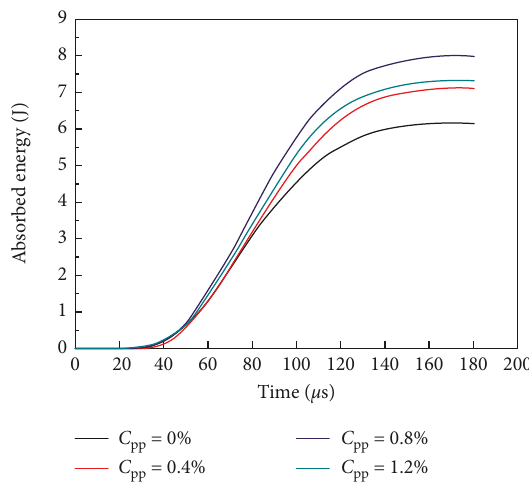
Figure 12: Time-history curve of absorbed